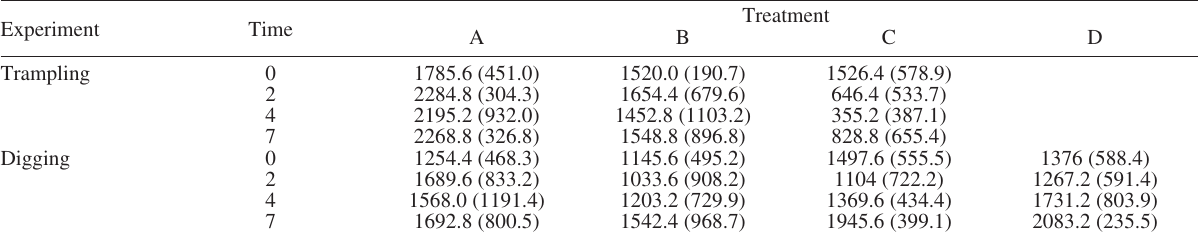
Table 2. – Means (and standard deviation) for plant shoot density (shoots m –2 ) in both pressure experiments (trampling and digging). Treat- ments: A, no pressure; B, light pressure; C, heavy pressure; D, continuous pressure. Experiment